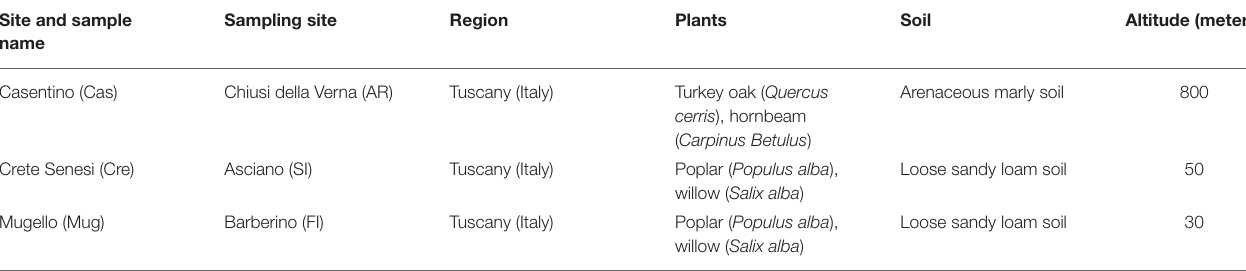
TABLE 1 | Sampling site and properties of sampling